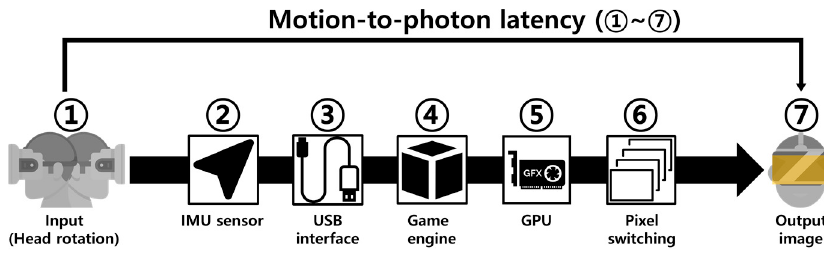
Figure 1. Overall process and motion-to-photon latency of the image rendering.